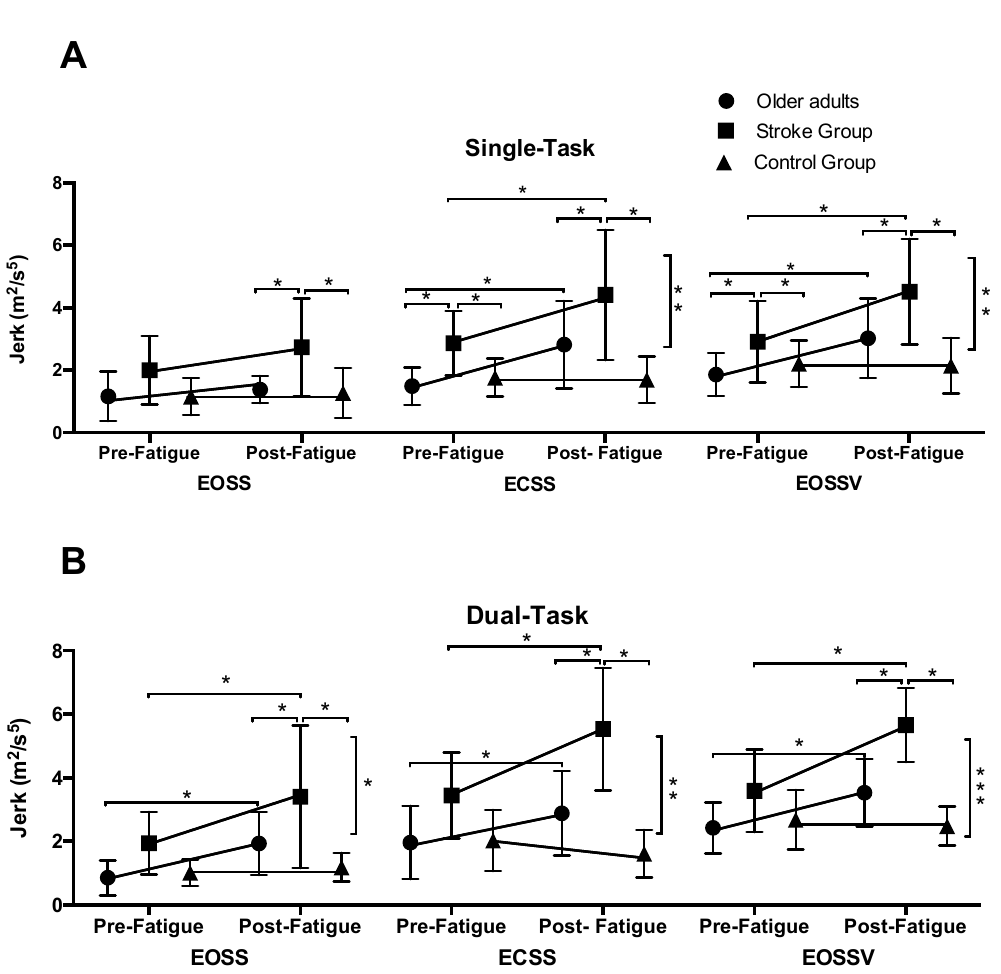
Figure 3. Shows the Jerk of COM values in each SOT condition for the older adults, stroke, and control groups recorded before and after the mental fatigue and control intervention, respectively, during the ( A ). Single-task protocol. ( B ). Dual-task protocol. Vertical bars represent the time by group effect. * p ≤ 0.05 ** p ≤ 0.01 *** p ≤ 0.001. Data are presented as the mean ± standard deviation.